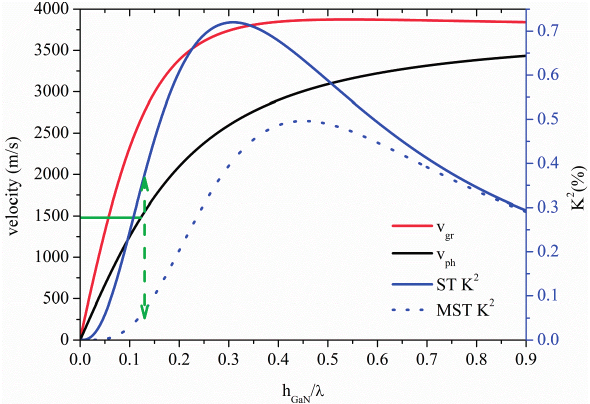
Figure 11. Phase and group velocity, and K 2 dispersion curves of the A 0 mode propagating along the MST and ST configurations on GaN plate.